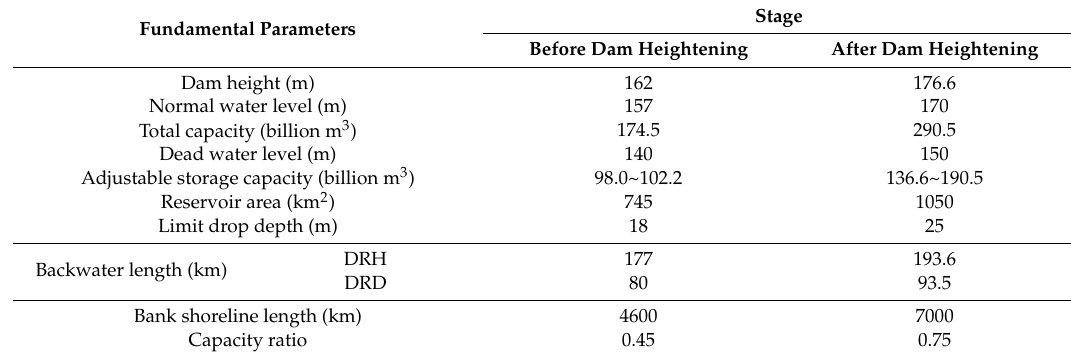
Table A1. Comparison of main characteristics of the Danjiangkou Reservoir before and after the dam heightening.